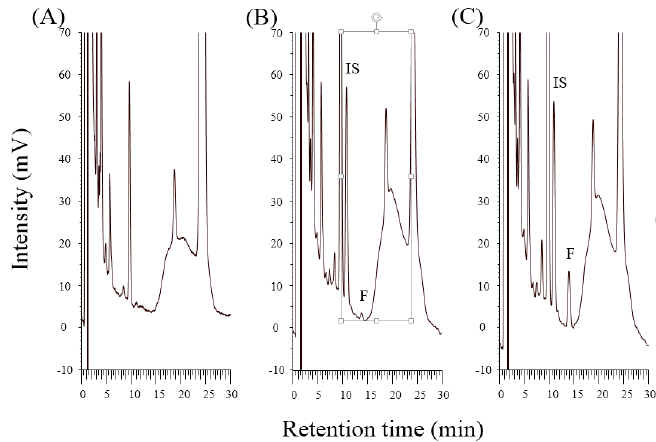
Figure 2. HPLC-EC chromatograms of ( A ) blank rat plasma; ( B ) blank plasma spiked forsythiaside (20 ng/mL) and ( C ) plasma sample collected 15 min after subcutaneous injection of forsythiaside hydrogel (3 mg/kg).